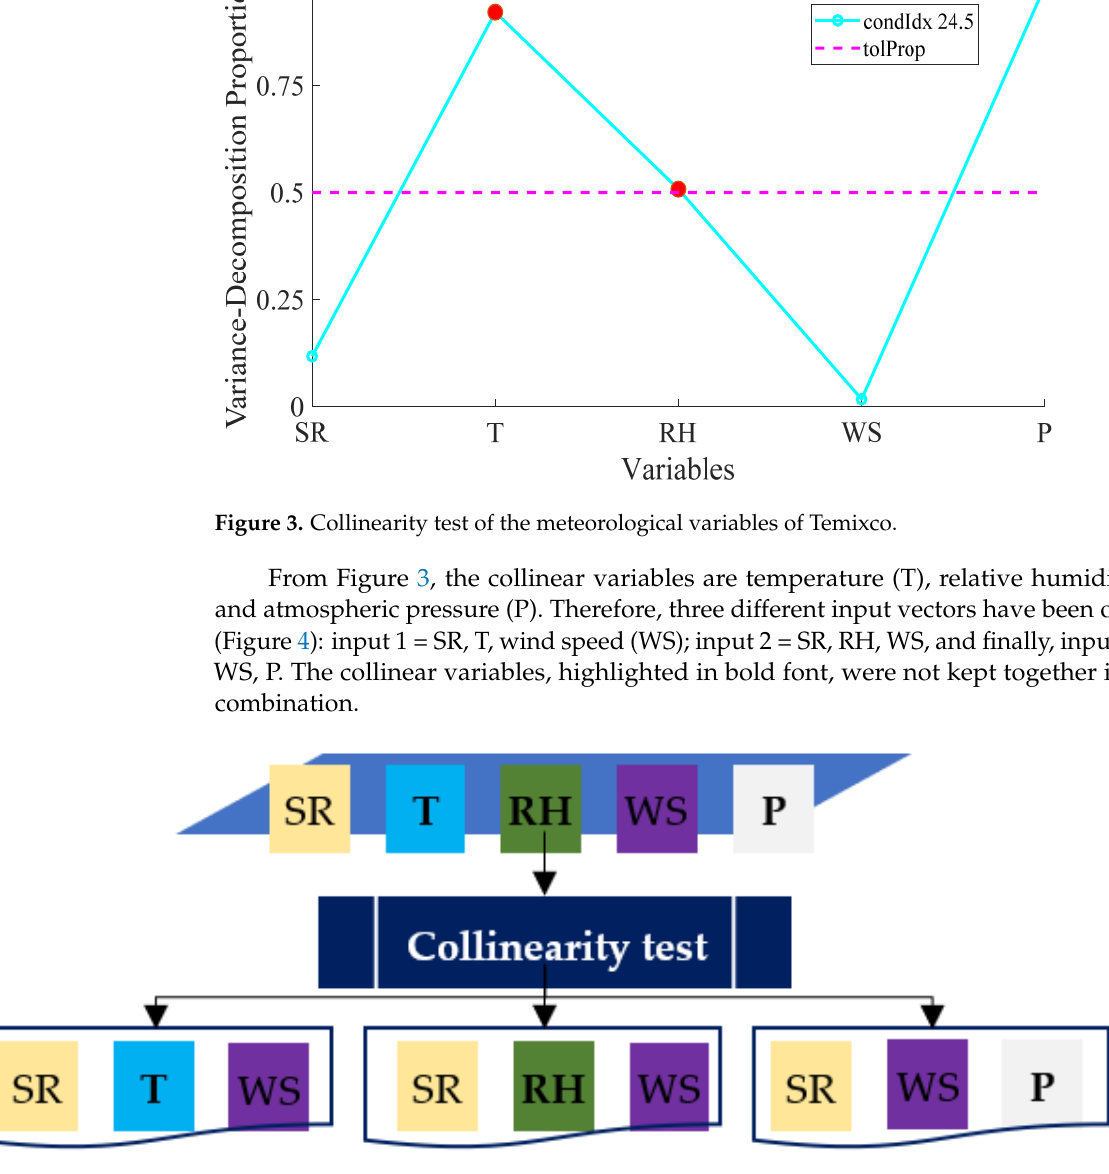
Figure 4. Meteorological variables combination.